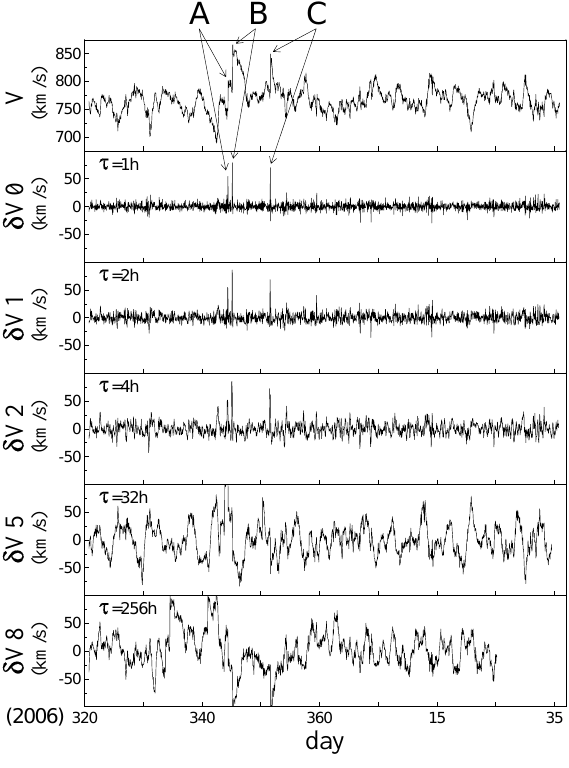
Fig. 3. From top to bottom: standard deviation, skewness, and kur- tosis versus time lag τ for the intervals of Table 2. Error bars for skewness and kurtosis are not appreciably larger than the marker size.